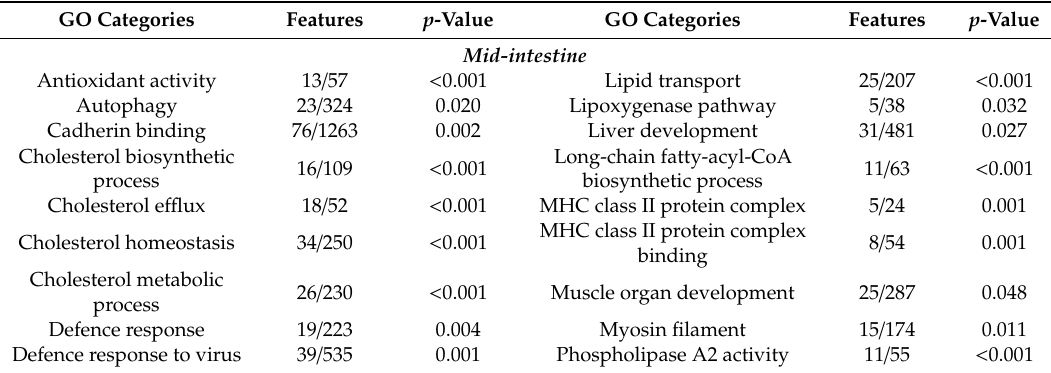
Figure 1. Differentially expressed genes (DEGs) in the intestine and liver of salmon fed with WG-containing diets (15% (WG15) or 30% (WG30)) in comparison to the FM control group ( n = 6). Table 5. Functional GO categories of genes that were differentially expressed in mid-intestine and liver of salmon fed with the WG-containing diets in comparison to the FM controls ( n = 6; two fish per three replicate tanks). Features represent the number of DEGs that were enriched of the genes included in the microarray platform. The significance ( p -value) of the enrichment was assessed by the Yates’ corrected chi-square values.